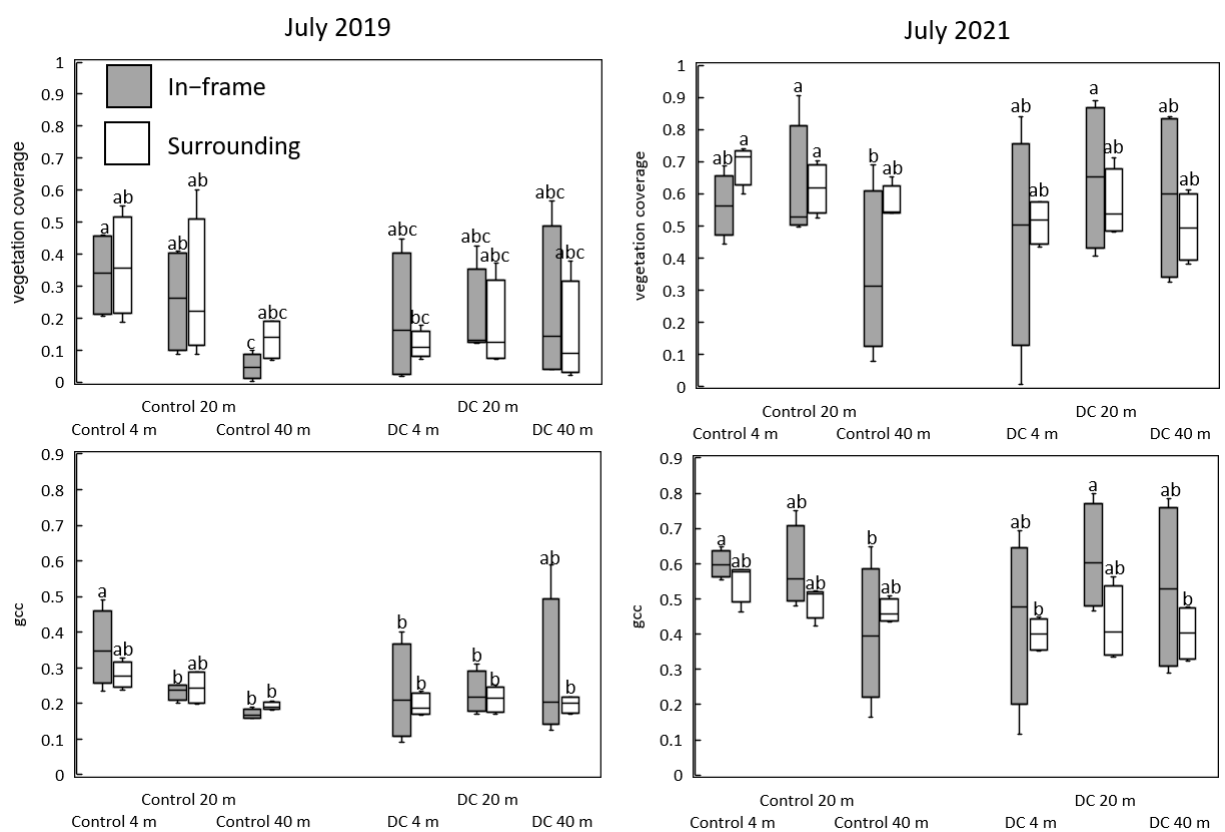
Figure 4. Ground vegetation greenness index inside the frames and in their surrounding areas within 15 m of each flux measurement plot in July 2019 and in July 2021, grouped by ditch cleaning treatment (control versus DC) and distance to ditches (4 m, 20 m and 40 m). The boxes denote the interquartile range with the median indicated inside each box, whereas the lines extending from the boxes indicate the range of each category. Different letters above boxes (a, b, c) refer to compact letter display of one-way ANOVA that indicate significant differences ( α = 0.05) among groups, followed by the least significant difference test.